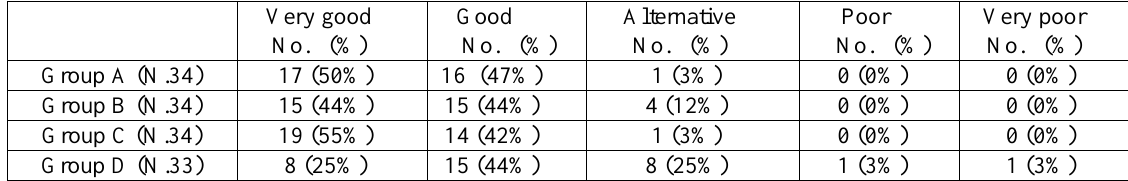
Table 5: Postoperative well-being scores Very